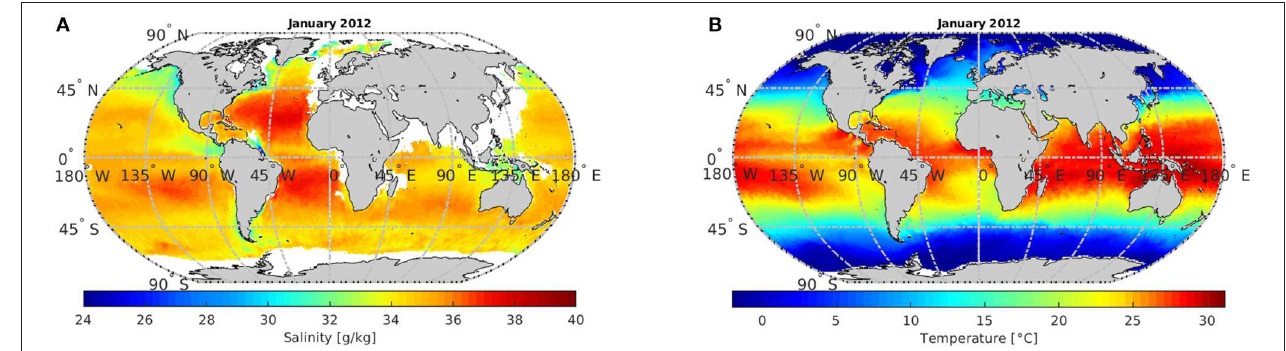
FIGURE 1 | SMOS global SSS map averaged over January 2012 (A) along with a global SST map derived from OSTIA (B) .